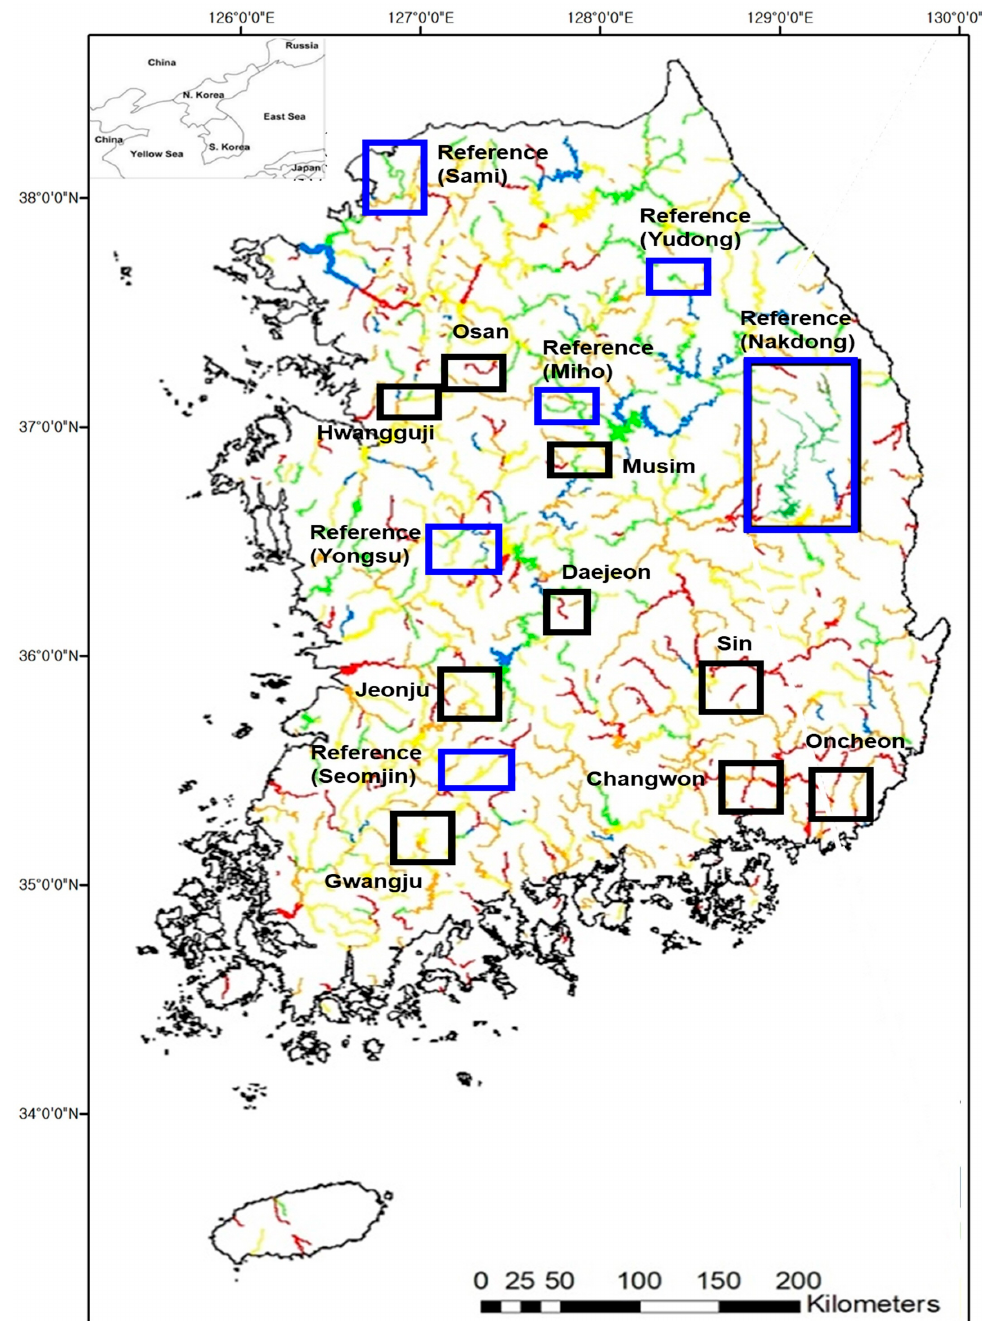
Figure 1. A map showing the areas where the streams selected for the evaluation of the restoration effects are located. Dot names indicate the river name. The colors on the map represent the naturalness grade evaluated based on the Riparian Vegetation Index [3].